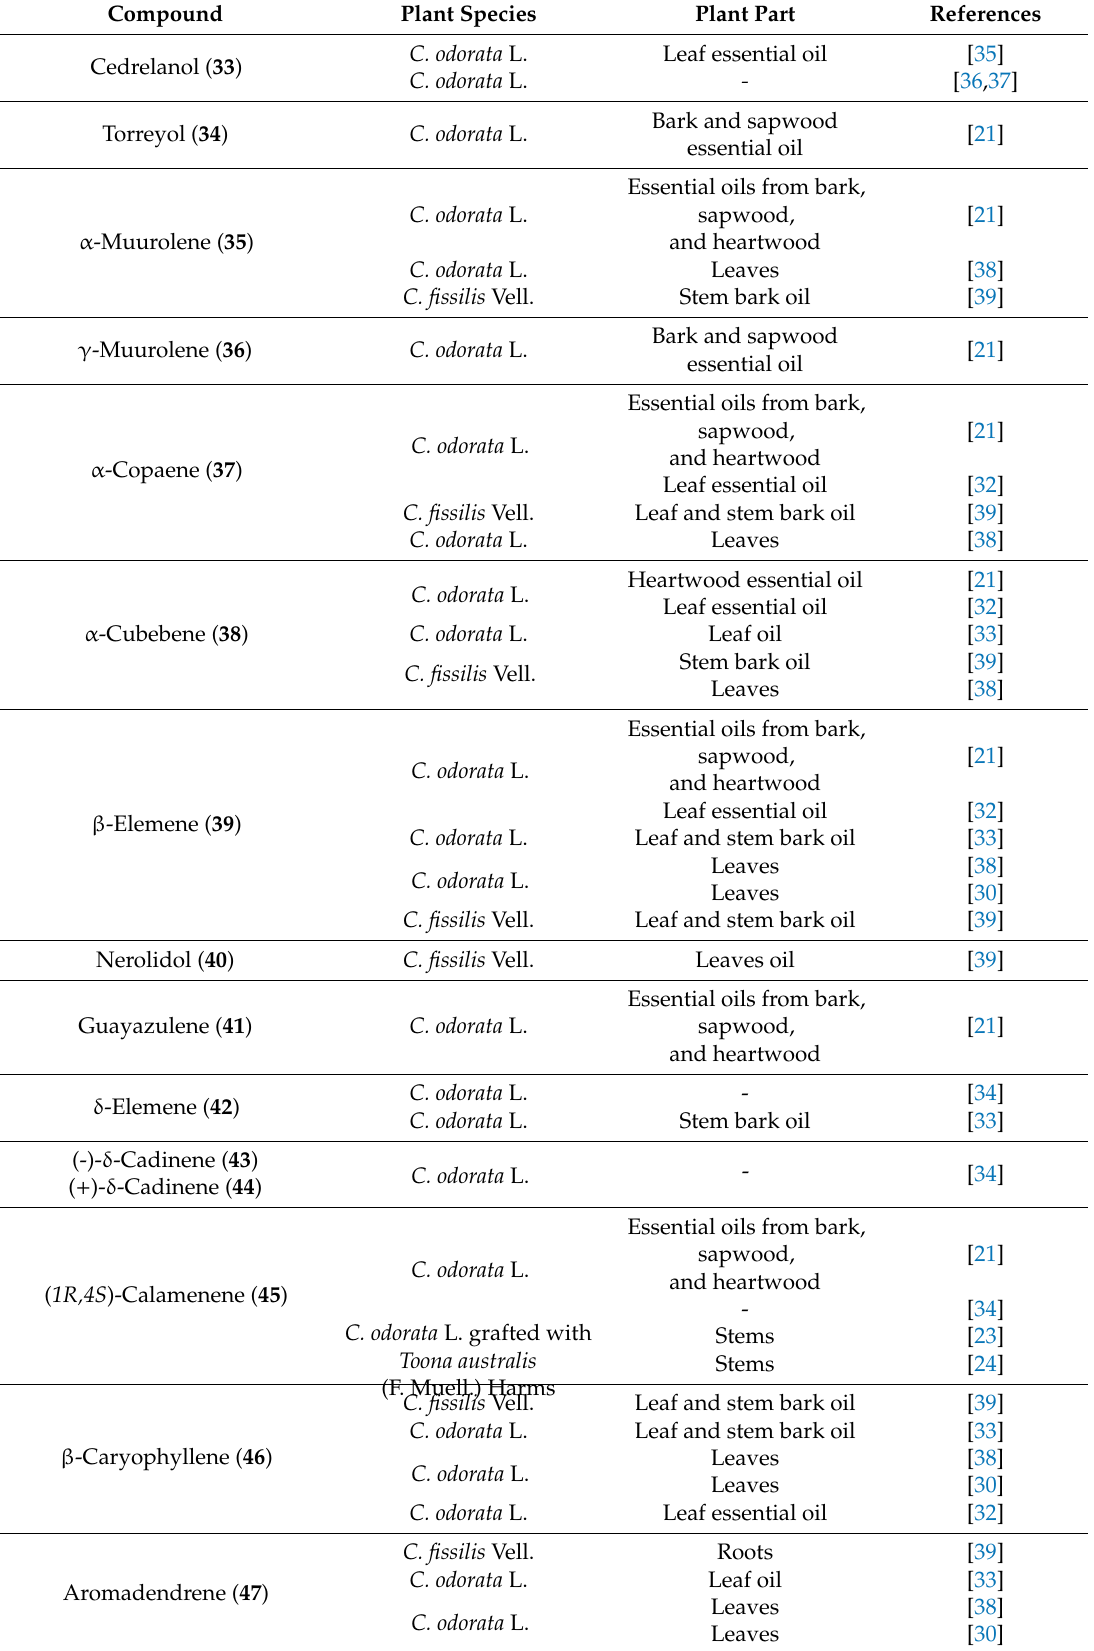
Table 5. Sesquiterpenes identified from the genus Cedrela